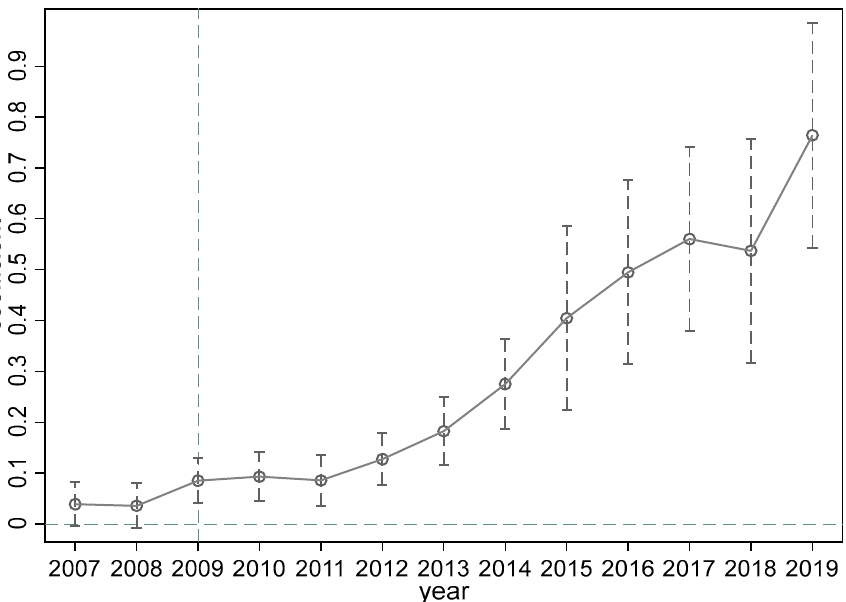
Figure 3. Parallel trend test results of the estimated parameters in Formula (5). Note: The x-axis represents the year before and after the construction of the NIIDZ. 2007 and 2008 are years before NIIDZ implementation. Further, 2009 represents the current year of policy implementation, and 2010–2019 represent years after policy implementation.